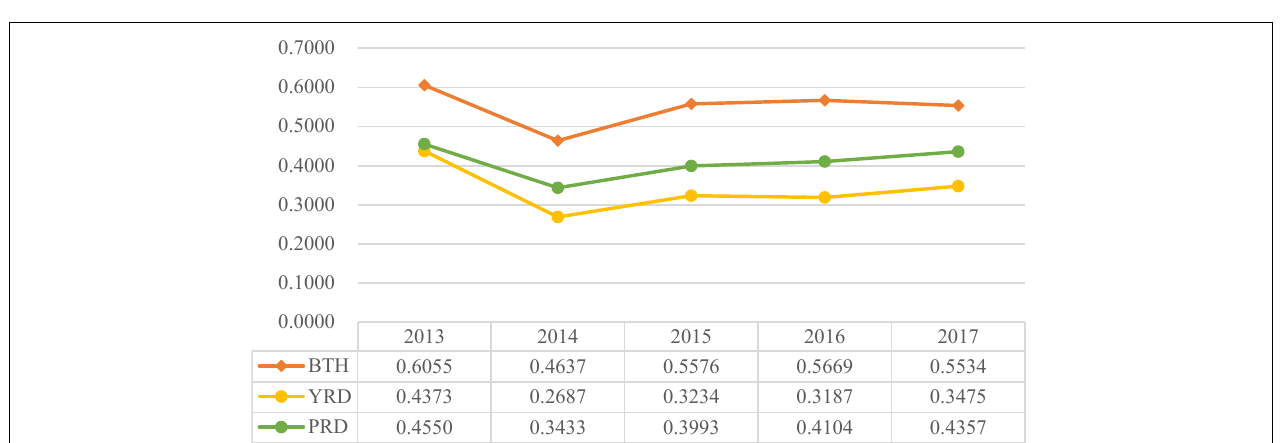
FIGURE 2 | Map of the three major urban agglomerations.